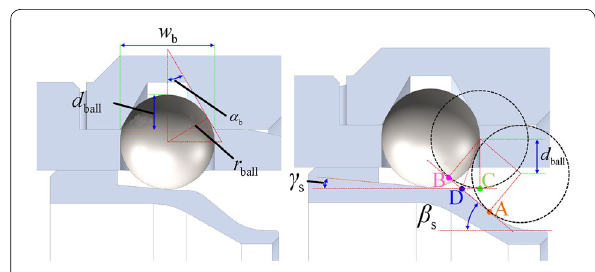
Figure 6 Tolerance designs of the RCM based on